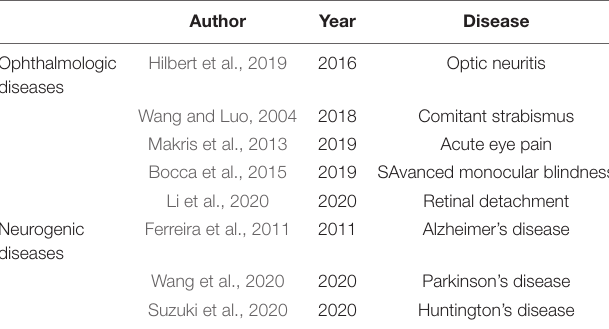
angular, right fusiform, and left frontal inferior orb regions.